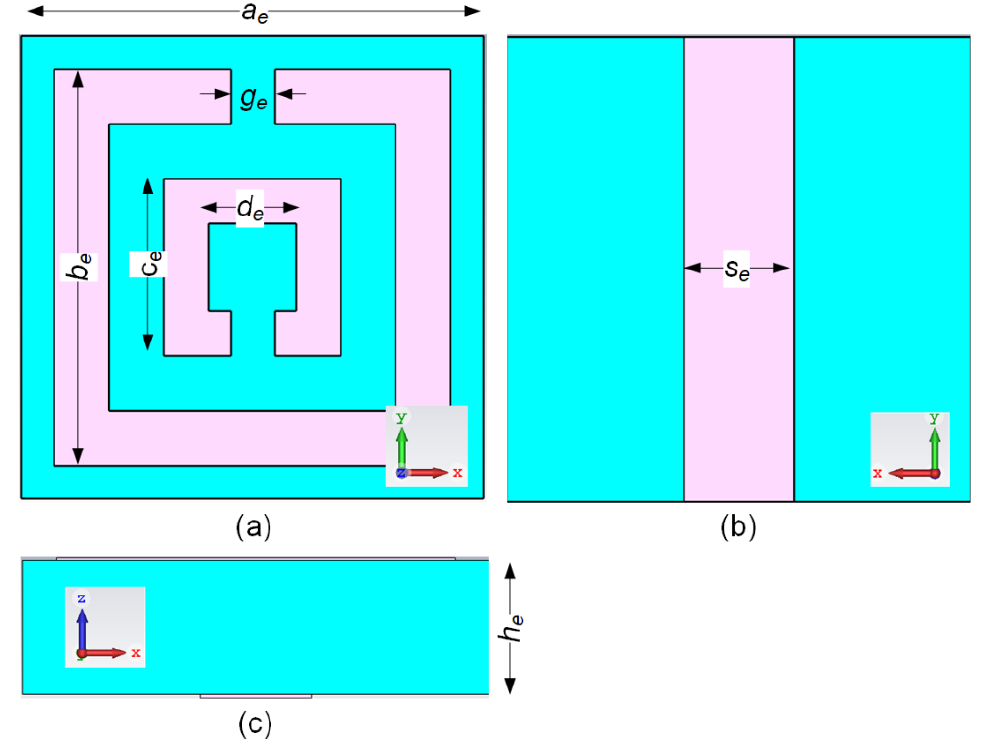
Figure 3. EBG unit cell structure: ( a ) top view, ( b ) bottom view and ( c ) side view.